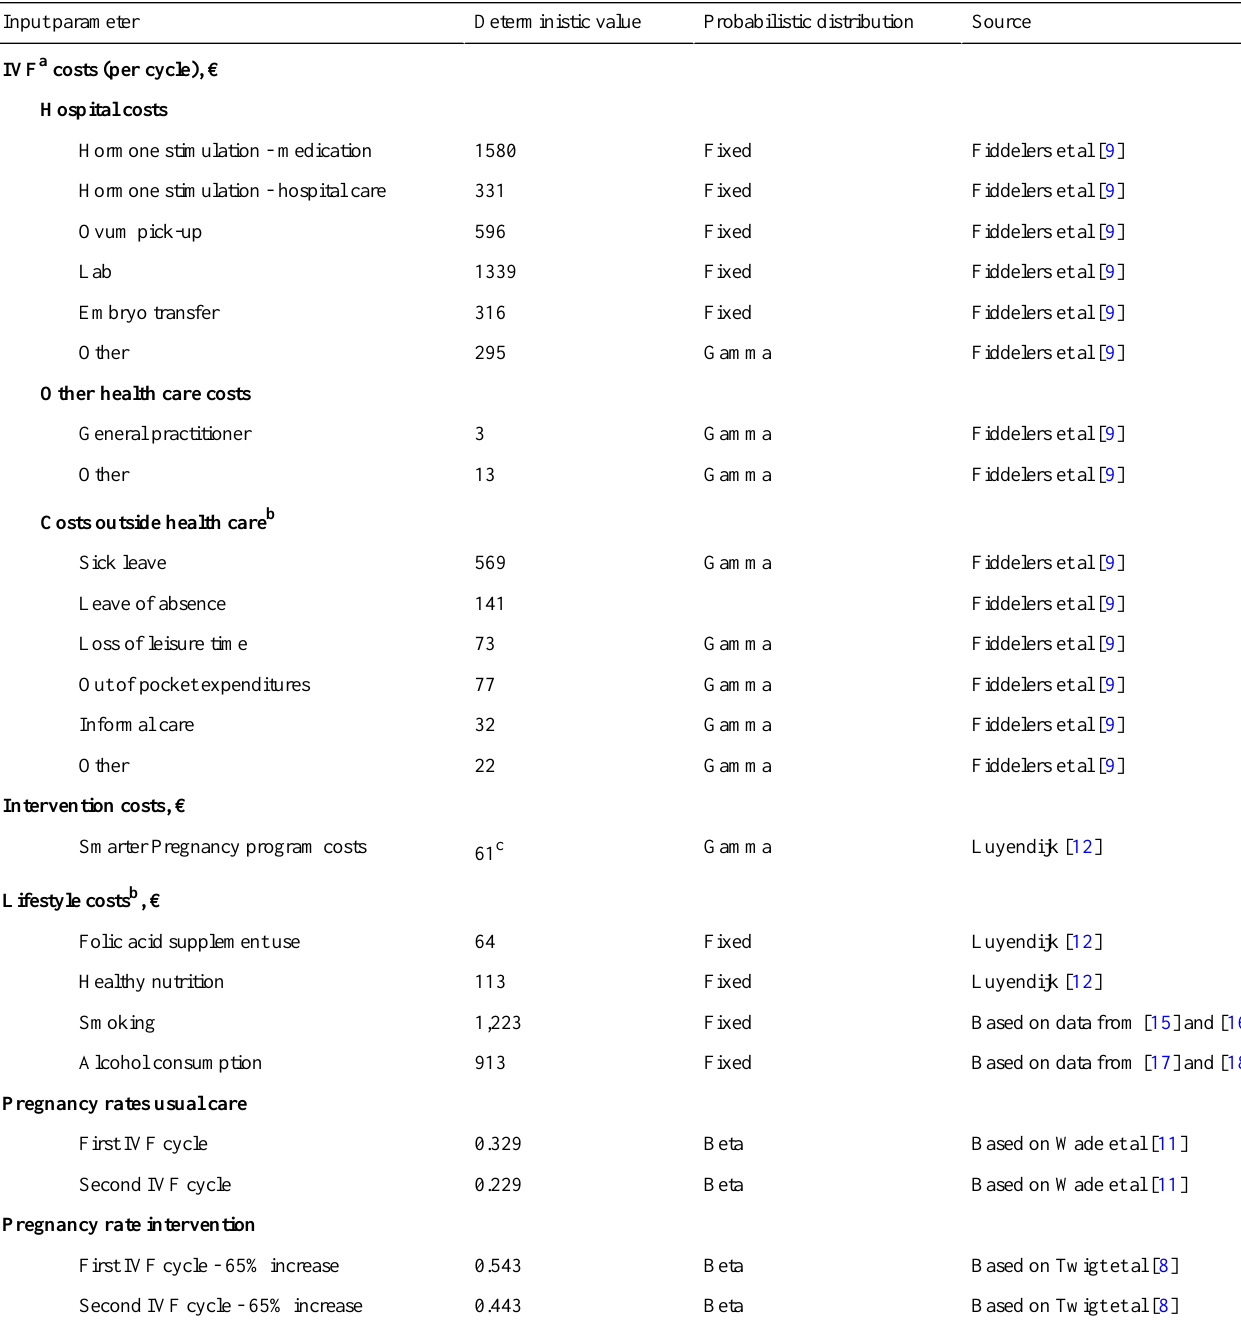
Table 1. Model input